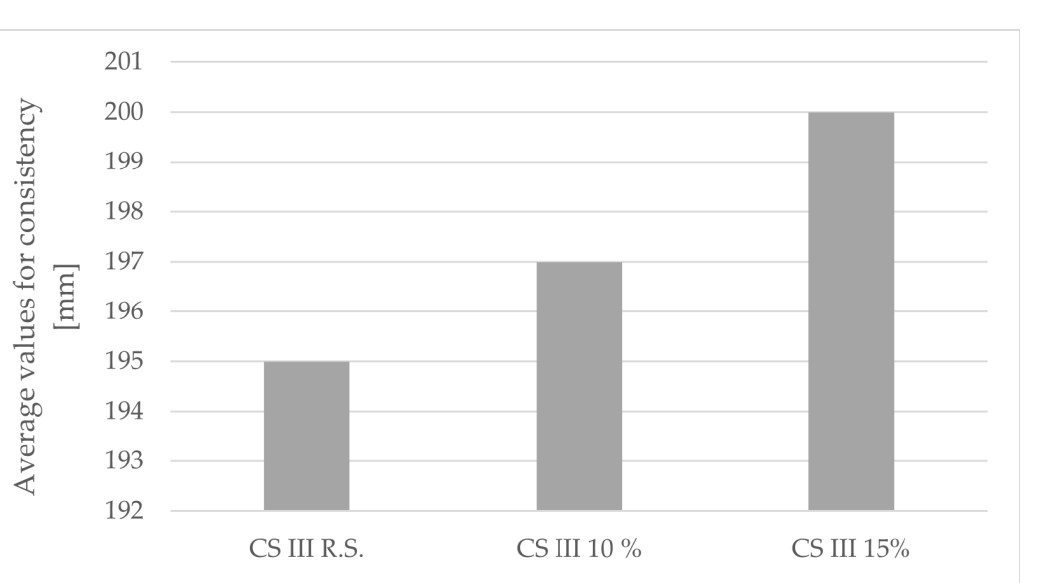
Figure 11. Mortars consistency depends on the percentage of dislocated aggregates.